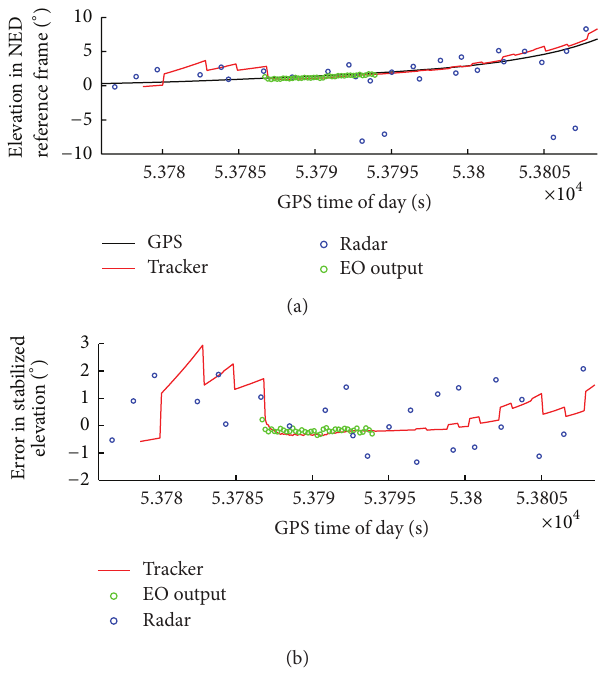
Figure 10: Intruder elevation in NED (GPS, tracker, radar, and EO output) and relative estimation errors (tracker, radar, and EO output with respect to GPS) as a function of GPS time in the considered